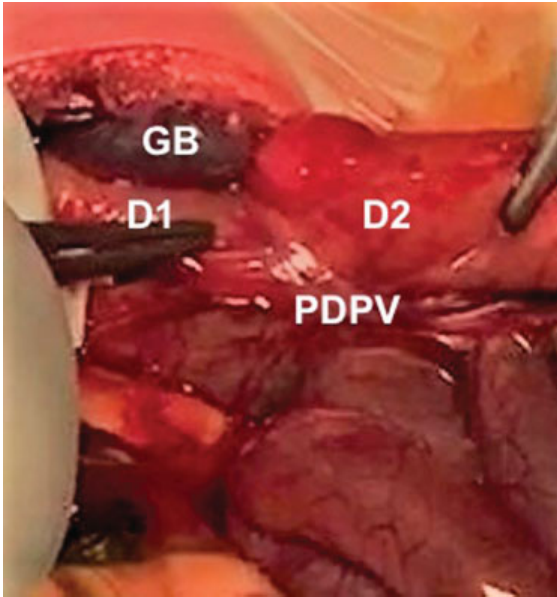
Fig. 2 Intraoperative aspect: preduodenal portal vein crossing the second part of the duodenum. D1, fi rst part of the duodenum; D2, second part of the duodenum; GB, gallbladder; PDPV, preduo- denal portal